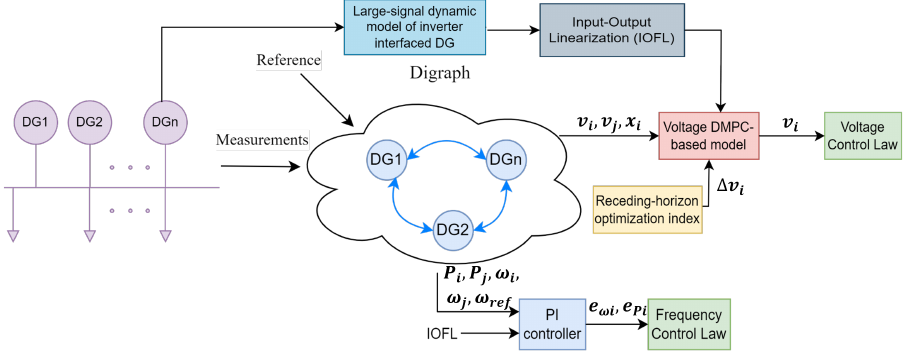
Figure 5. Diagram of the implemented secondary predictive controller based on an input–output linearization of the DG inverter